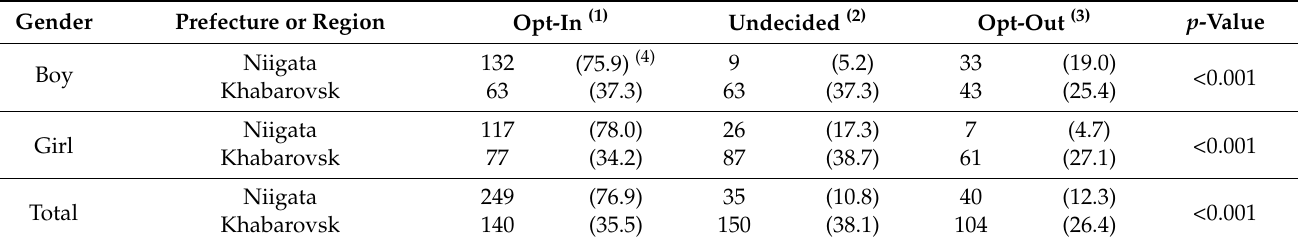
Table 10. Numbers and percentages of adolescents by nation and gender in response to the question “What do you think about the COVID-19